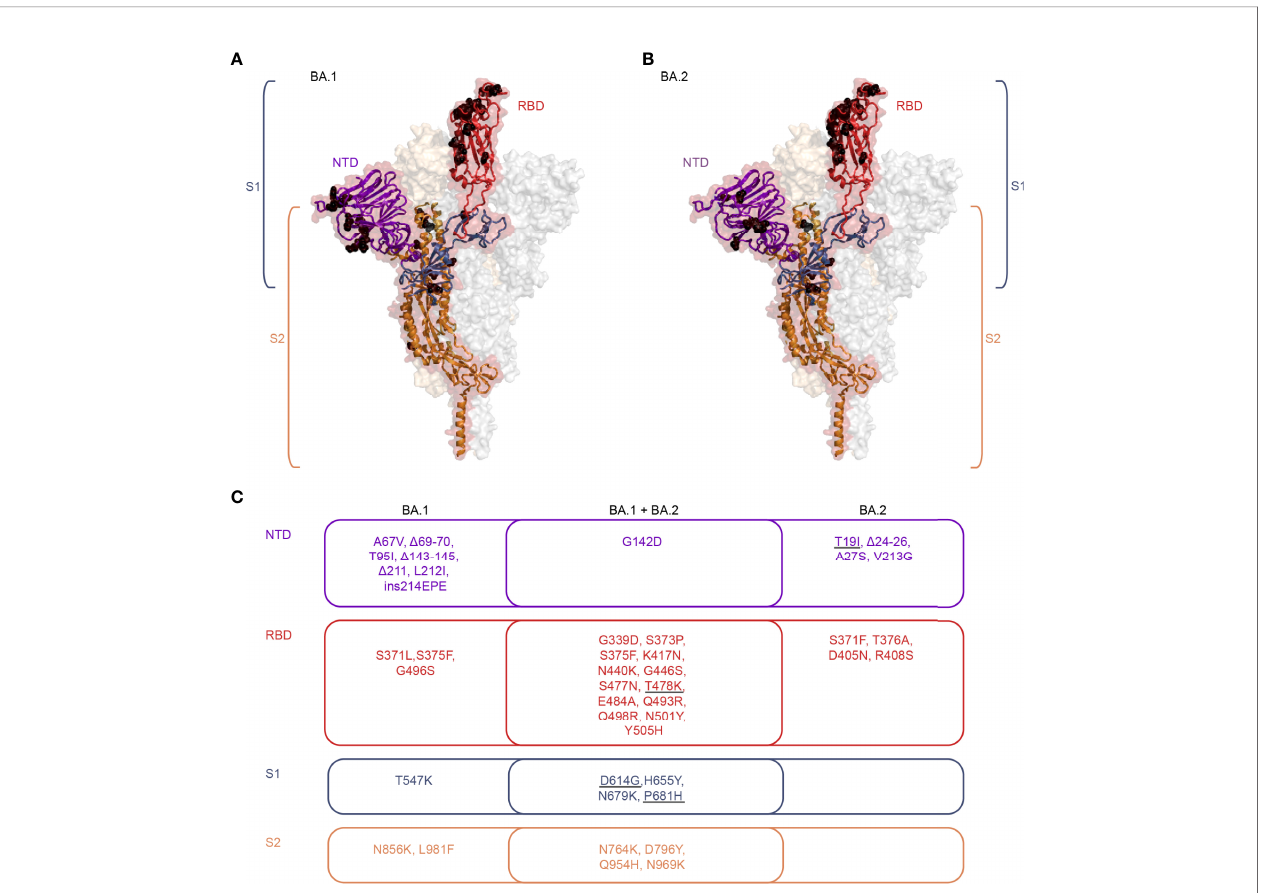
FIGURE 2 | Structural representation of mutations present in Omicron BA.1 and BA.2 sub-lineages. (A, B) Cartoon representation of one monomer of the spike protein (side view) combined with a semi-transparent surface representation of the trimeric spike in its RBD-up-conformation [PDB 7KRR, (25)]. The three protomers are colored in red, grey, and bright orange. The S1 subunit is colored blue in the single protomer, with the RBD highlighted in red and the NTD highlighted in purple. S2 is colored in orange. The black spheres indicate the mutations present in sub-lineages BA.1 (A) and BA.2 (B) . The structures were generated with PyMol (https:// pymol.org). (C) Venn diagram illustrating the BA.1 and BA.2 sub-lineage-speci fi c and shared mutations, colored according to the regions highlighted in panels A and B. The grey underlines indicate mutations present in the Delta variant. RBD, Receptor-binding domain; NTD, N-terminal domain; S1, Subunit 1; S2, Subunit